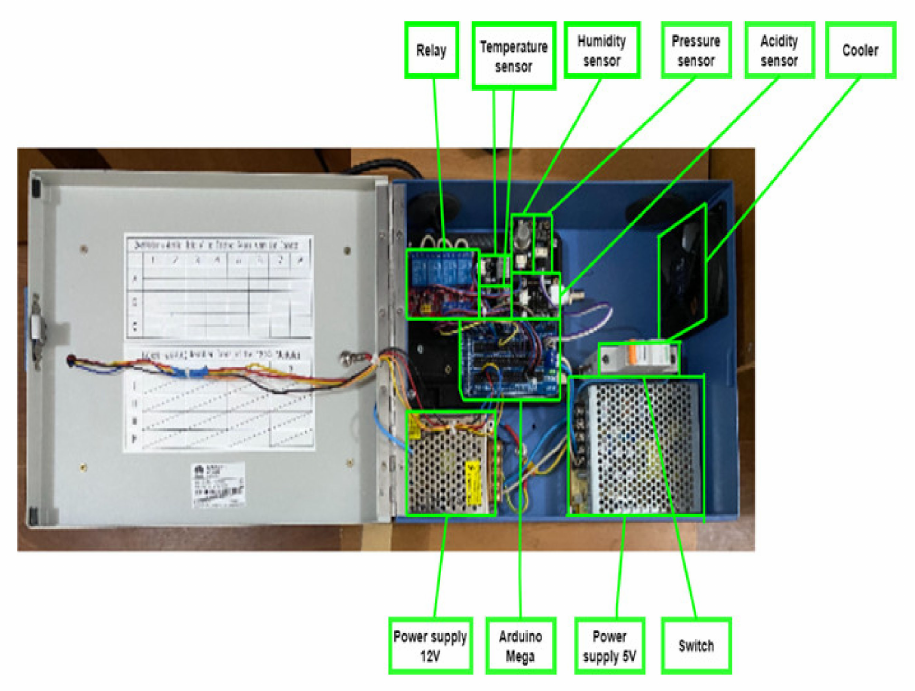
Figure 6. Photo of the controller with the cover removed.